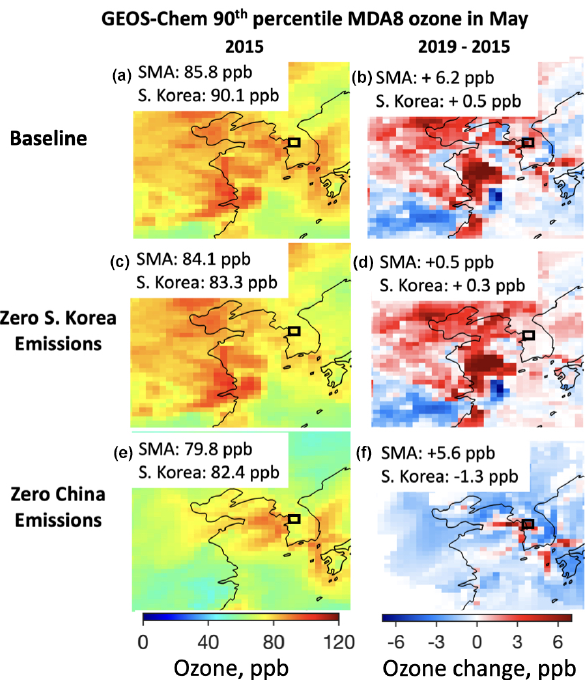
Figure 11. Emission-driven ozone changes over East Asia from 2015 to 2019 in GEOS-Chem. Results show the 90th percentile MDA8 ozone for May simulated by GEOS-Chem using 2015 emis- sions, as well as the difference using 2019 emissions, both for the same meteorological year. Panels (a) and (b) show the baseline simulation described and evaluated with observations in Sect. 5. Panels (c) – (f) show sensitivity simulations with zero anthropogenic emissions in South Korea and China, respectively. Spatially aver- aged values for the Seoul metropolitan area (SMA) and South Korea are given